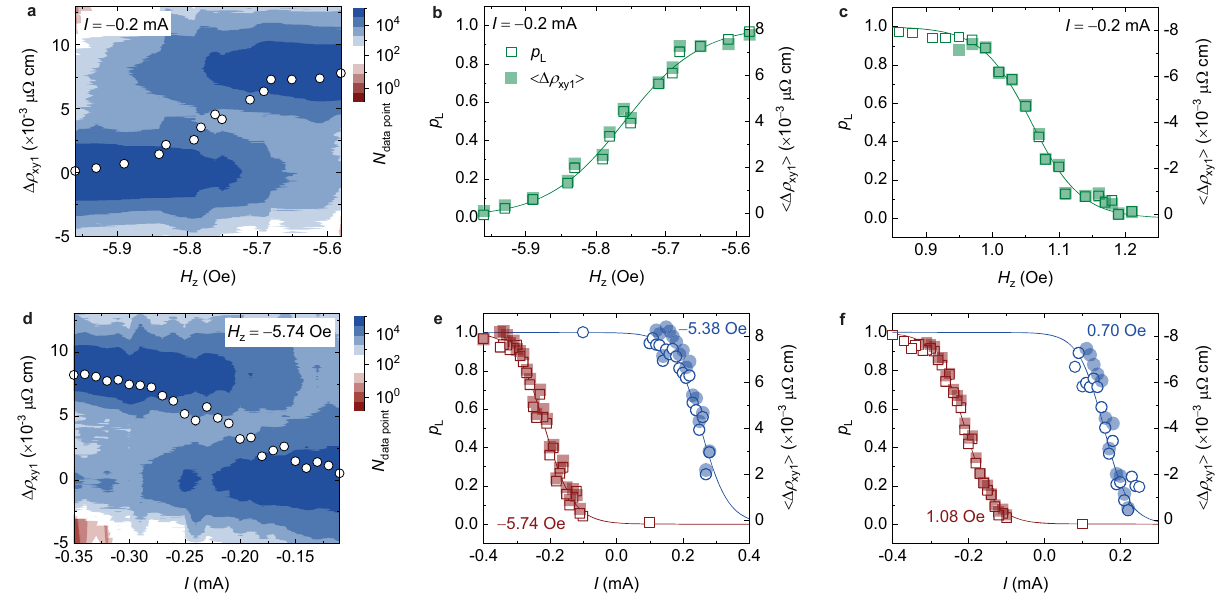
Fig. 2 Field and current control of the switching. a Statistics of data point distributions as a function of Δ ρ xy1 in the presence of different fi elds H z and at a constant current I = − 0.2 mA. Open dots represent the results of time-averaged Δ ρ xy1 , 〈 Δ ρ xy1 〉 . b , c The fi eld H z dependencies of the switching probability p L (open dots) and 〈 Δ ρ xy1 〉 (solid dots). d Statistics of data point distributions with different currents I and at a constant fi eld H z = − 5.74 Oe. e , f Current I dependencies of p L (open dots) and 〈 Δ ρ xy1 〉 (solid dots) at different fi elds. Lines are sigmoidal fi ts. All results are measured at 307.1 K. Results in a , b , d , e are for the skyrmion shown in Fig. 1b with upward orientations of magnetization ( z axis) in the skyrmion core. Results in c and f are for the skyrmion with a reversed polarity (downward orientations of magnetization ( − z axis) in the skyrmion core) created at the same